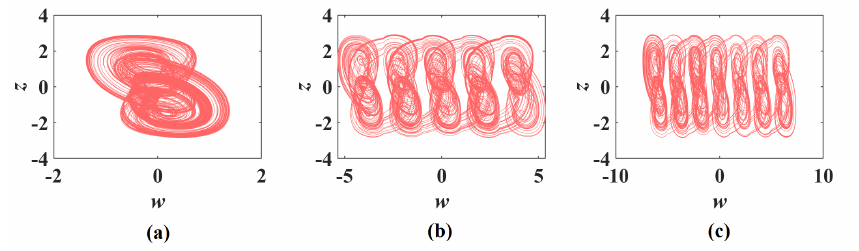
Figure 4. Multi-scroll attractors with different parameters in w-z plane. ( a ) N = 1; ( b ) N = 2; ( c ) N = 3.